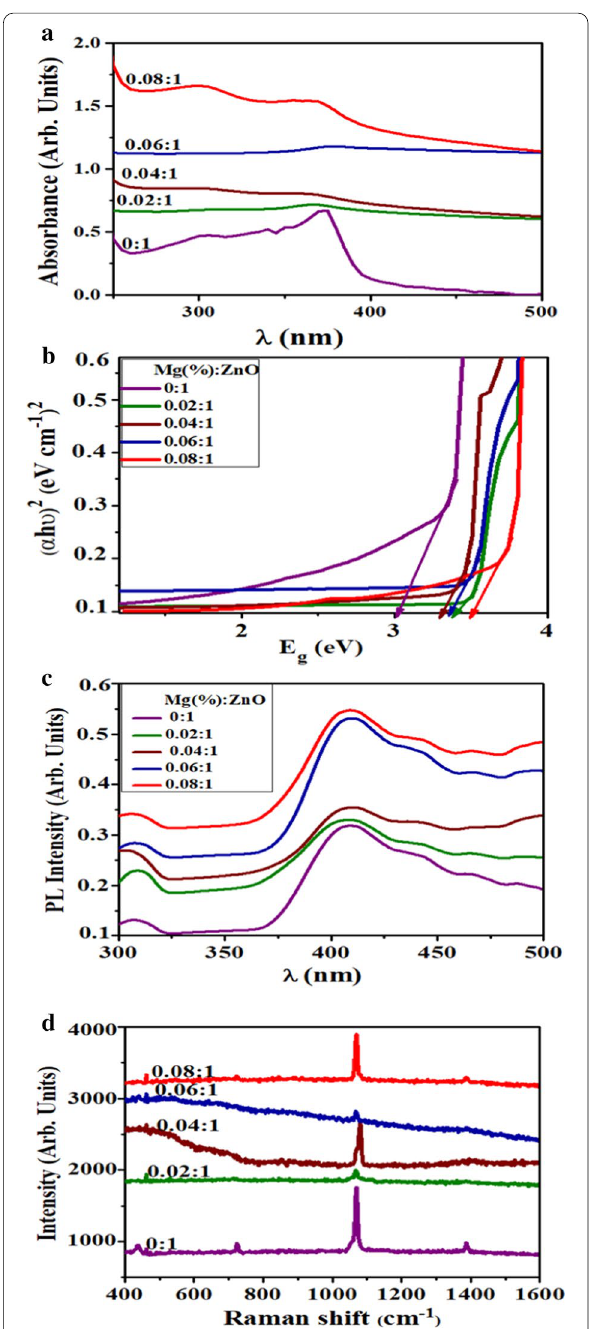
Fig. 3 a Absorption spectra of samples of Mg‑doped ZnO, b Tauc plot, c PL spectra and d Raman spectra of Mg‑doped ZnO